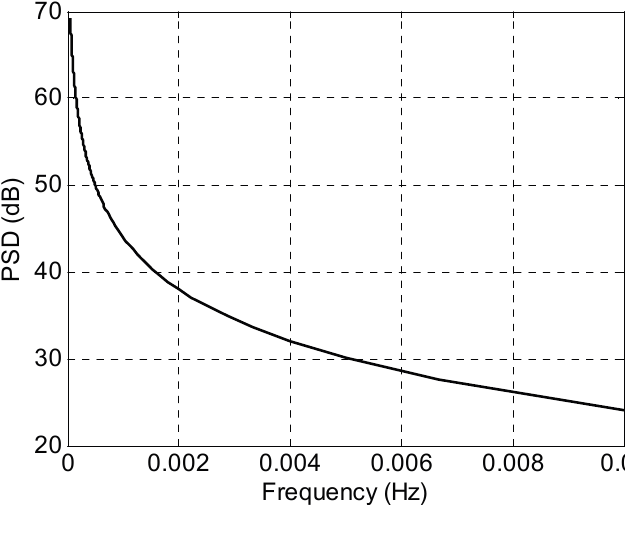
Figure 11. Power spectral density (PSD) of the angular random